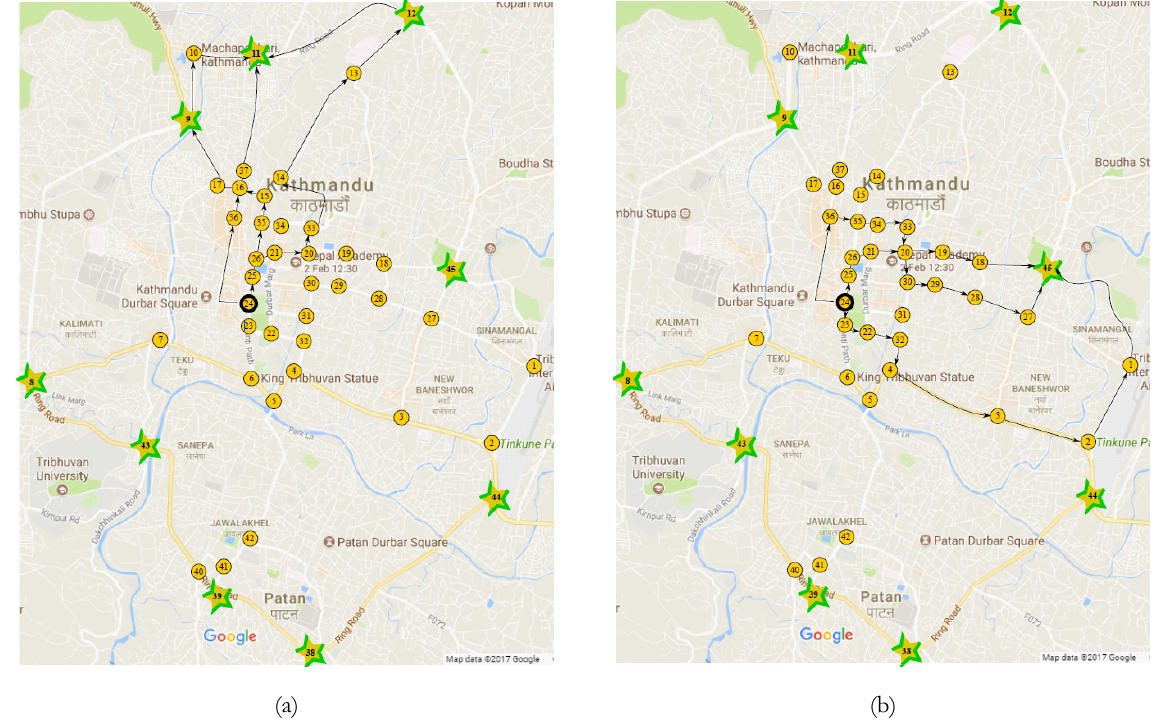
Figure 4: Kathmandu network with (a) Node 11 as MaxDynamic sink (b) Node 45 as MaxDynamic sink with